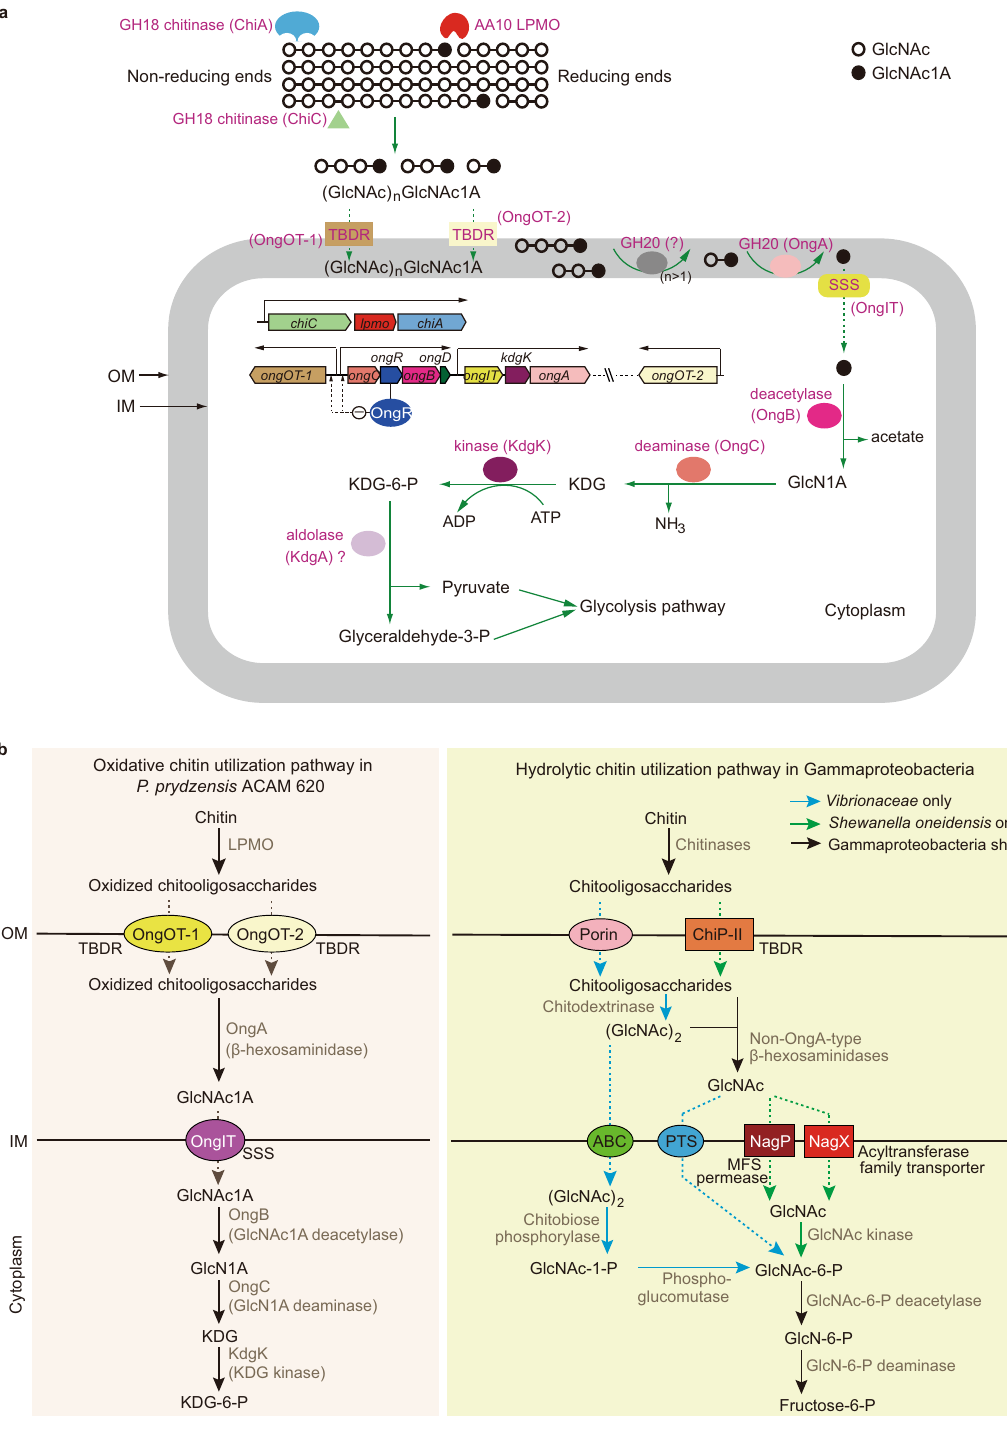
ACAM 620 (Supplementary Table 3) into pyruvate and glyceraldehyde- 3-P to enter the glycolysis pathway. In addition, OngR regulates the oxidative chitin utilization pathway in strain ACAM 620 mainly through repressing the transcription of the ongOT-1 and ongCRBD operons. In the well-characterized hydrolytic chitin utilization pathway (Fig. 5b), chitinases degrade chitin into chitooligosaccharides which are imported across the outer membrane by a speci fi c porin in the Vibrionaceae 35 orapredictedTBDR in S.oneidensis 11 .Non-OngA-type β - hexosaminidases in the periplasm hydrolyze